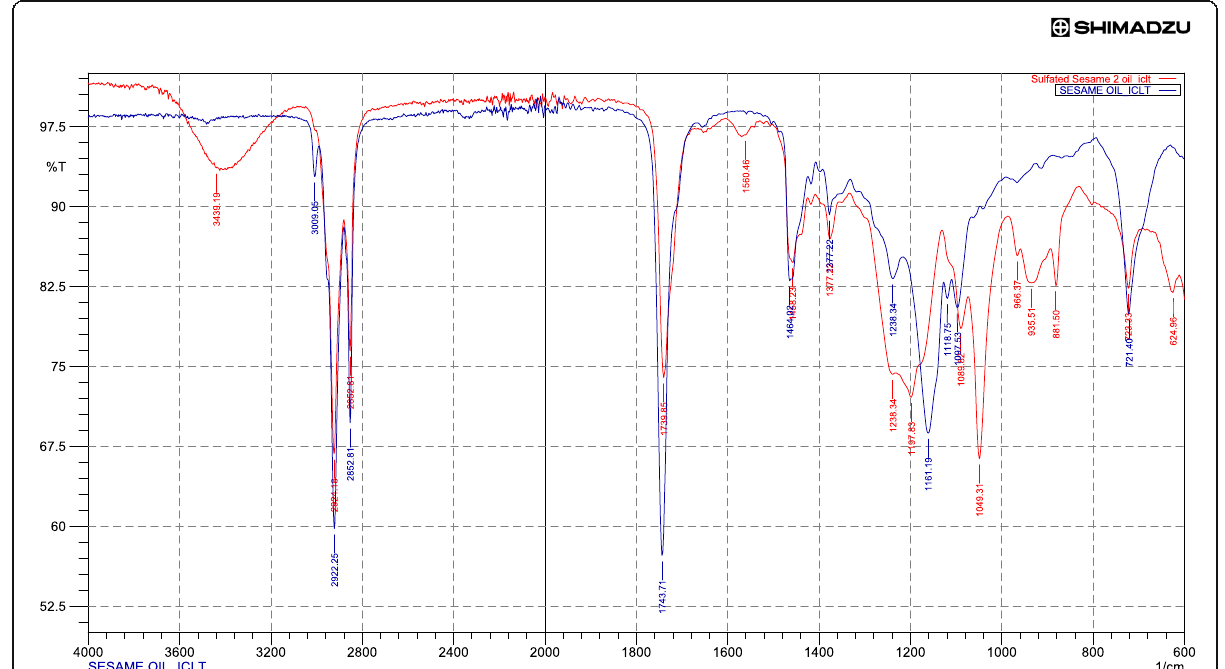
Fig. 2 FT-IR spectra of S. indicum oil before sulfonation (blue), and after sulfonation (red)